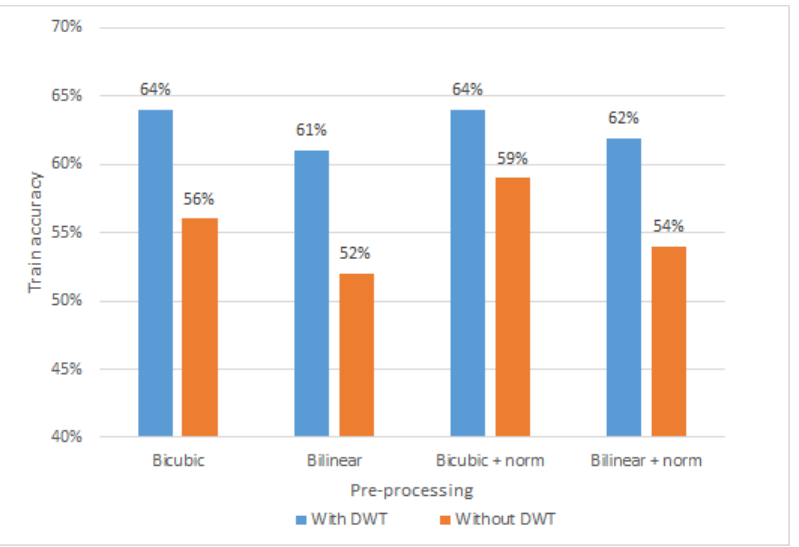
Figure 13. Discrete Wavelet Transform and batch normalization pre-processing results.